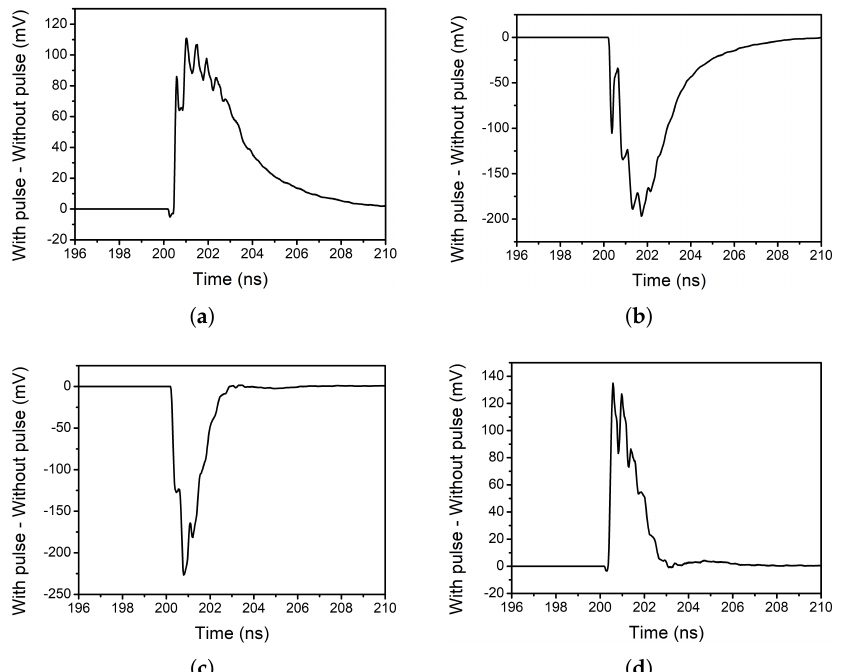
Figure 12. Effect of the pulse on the outputs of the mixer: ( a ) positive I branch, ( b ) negative I branch, ( c ) positive Q branch and ( d ) negative Q